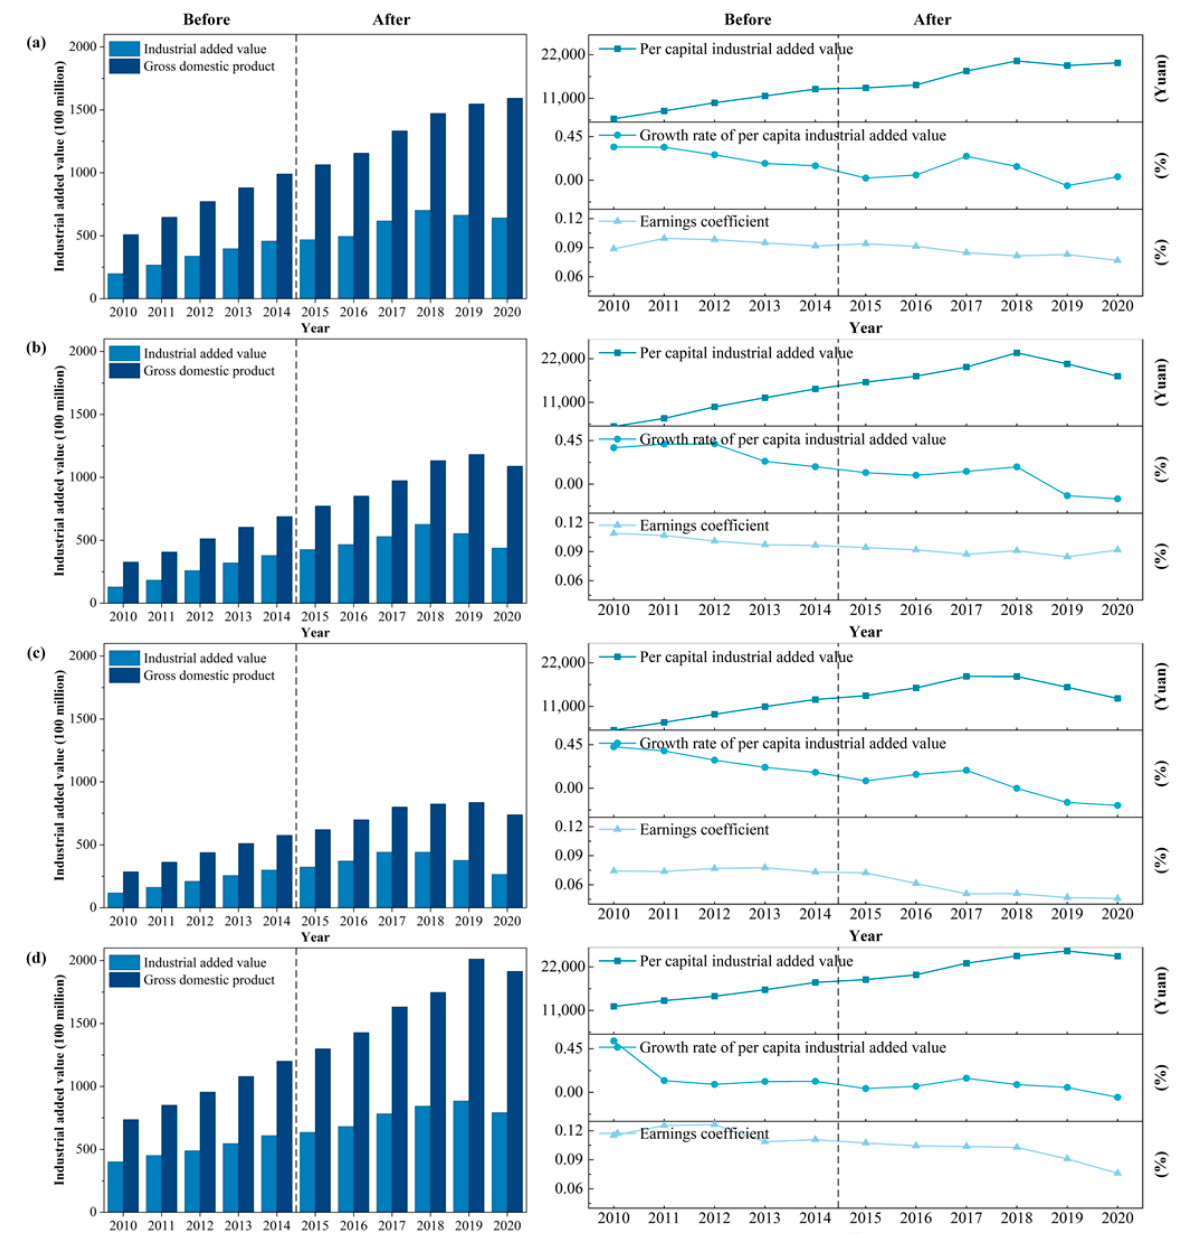
Figure 3. Changes in the main economic indicators of ( a ) Hanzhong, ( b ) Ankang, ( c ) Shangluo, and ( d ) Shiyan among the main headwater areas before and after the start of the middle route project from 2010 to 2020. Table 3. The opportunity cost of secondary industry producers in the main headwater areas from 2015 to 2020 (100 million).